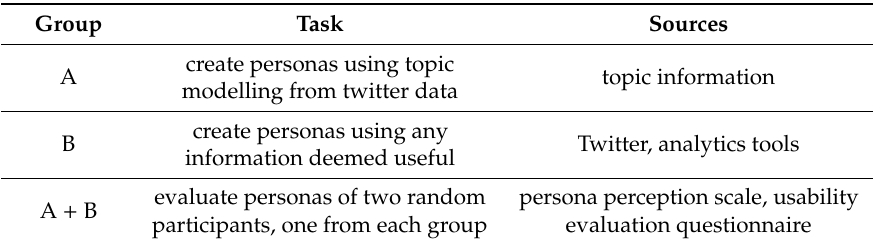
Table 1. Persona construction and evaluation task breakdown.